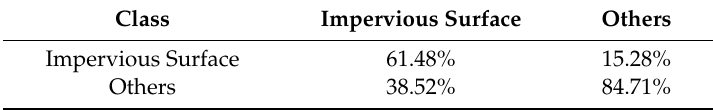
Table 8. Confusion matrix of construction on the image before